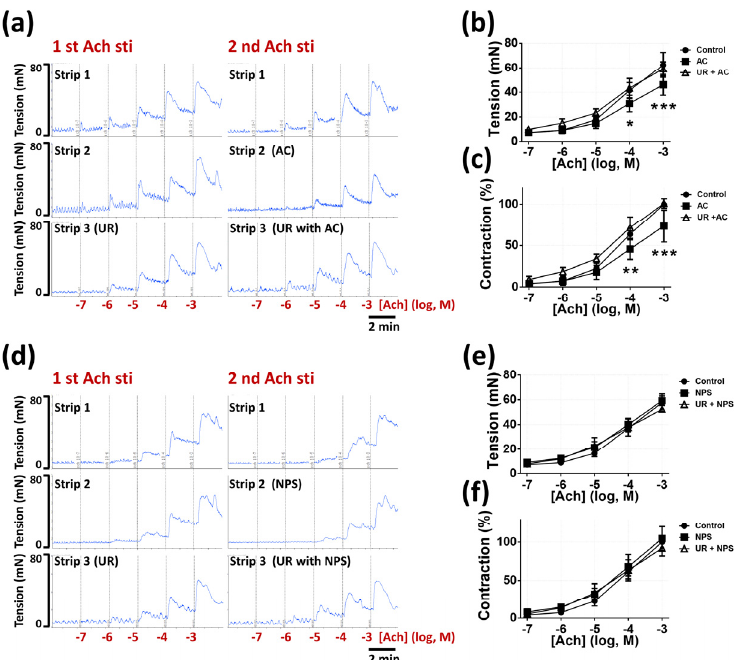
Figure 3. The effects of CaSR agonist (AC) and CaSR antagonist (NPS) on bladder strips contraction. The recording of contraction in response to the first and the second time of acetylcholine stimulations (sti) (from 1 × 10 − 7 to 1 × 10 − 3 M) in each group, which were added with different treatments before the second time of stimulations. ( a ) Contraction responses before and after added with buffer (control) (strip 1, intact strips) or 0.1 mM AC (strip 2, intact strips) or 0.1 mM AC (strip 3, urothelium removal strips). ( d ) Contraction responses before and after added with buffer (control) (strip 1, intact strips) or 0.1 mM NPS (strip 2, intact strips) or 0.1 mM NPS (strip 3, urothelium removal strips). The statistical analysis of contraction curves affected by AC ( b , c ) and NPS ( e , f ) in intact and urothelium removal strips (Two-way ANOVA with Sidak’s post hoc tests, n = 6 for each group; * p < 0.05, ** p < 0.01, *** p < 0.001, as compared with the control group).